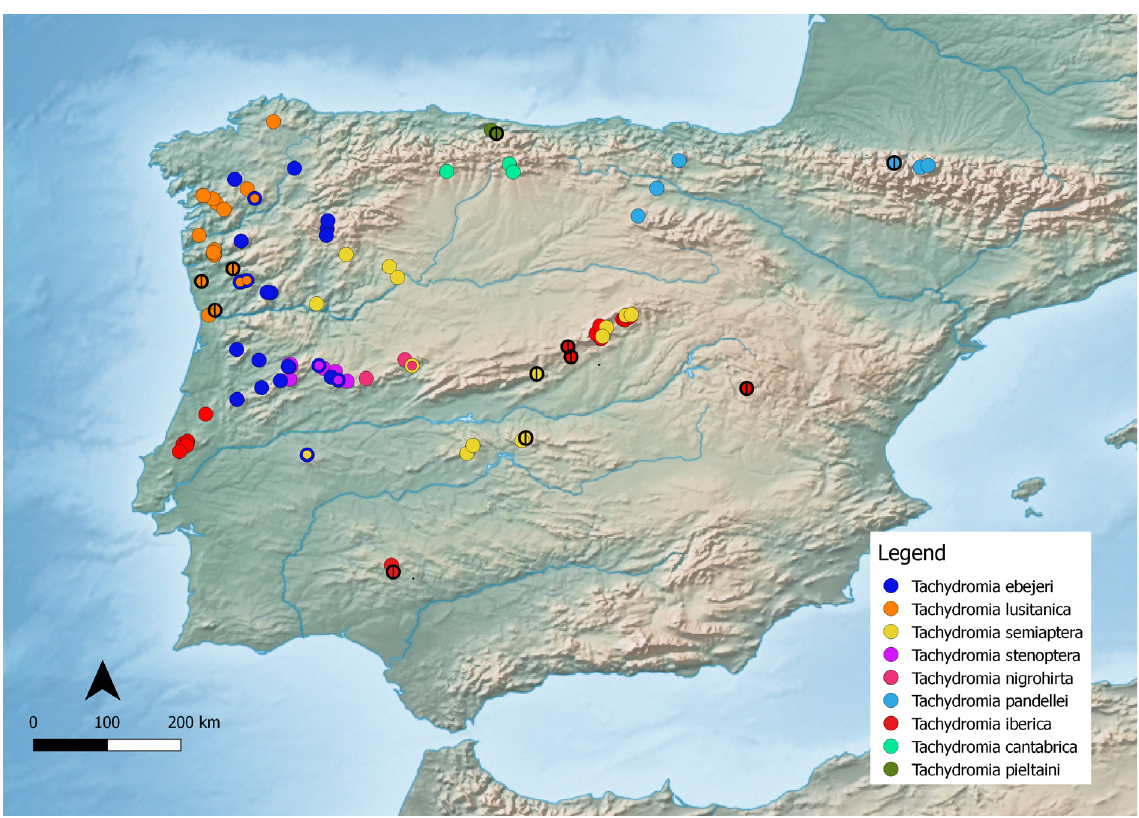
Fig. 1. Currently known distribution of the Iberian ant-like Tachydromia Meigen, 1803. Each dot represents a presence point, with each colour corresponding to a different species. When two species co-occur in the same area, their presence is represented by a smaller dot on top of a dot of regular dimension, each of those with the colour corresponding to the co-occurring species. The dots surrounded by a black circle with a vertical line represent localities